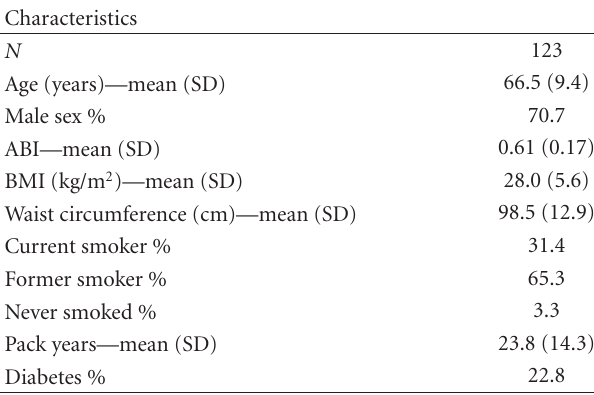
Table 1: Baseline characteristics of